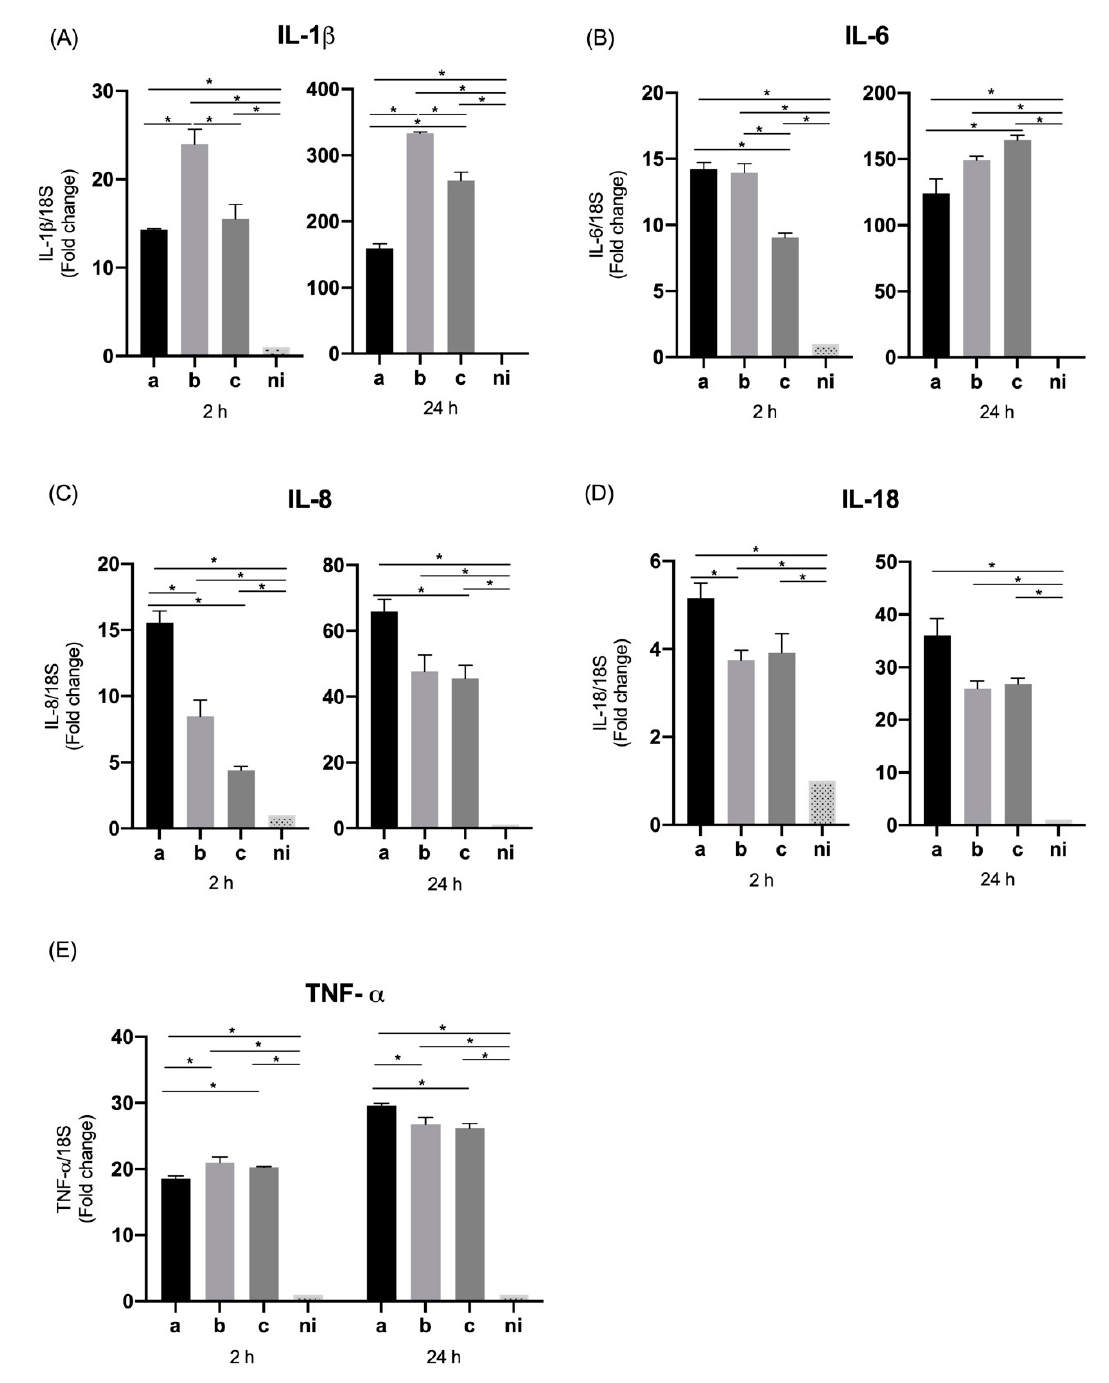
Figure 5. Cytokines and chemokines mRNA expression by A. actinomycetemcomitans -induced THP-1 human macrophages (ATCC ® TIB-202™). Expression in macrophages infected at a MOI = 10 2 with strains ATCC ® 43717 TM (serotype a), ATCC ® 43718 TM (serotype b), and ATCC ® 43719 TM (serotype c), 2 and 24 h after infection. For relative expression, mRNA expression in non-infected (ni) macrophages was considered as 1, as a reference for fold-change in expression using 18S rRNA expression levels as a normalizing endogenous control. Data are represented as fold-change means and standard deviation of three independent experiments performed in duplicate. ( A ) IL-1 β , ( B ) IL-6, ( C ) IL-8, ( D ) IL-18, and ( E ) TNF- α . Asterisks were used to indicate a value of p considered statistically significant (* p < 0.05).